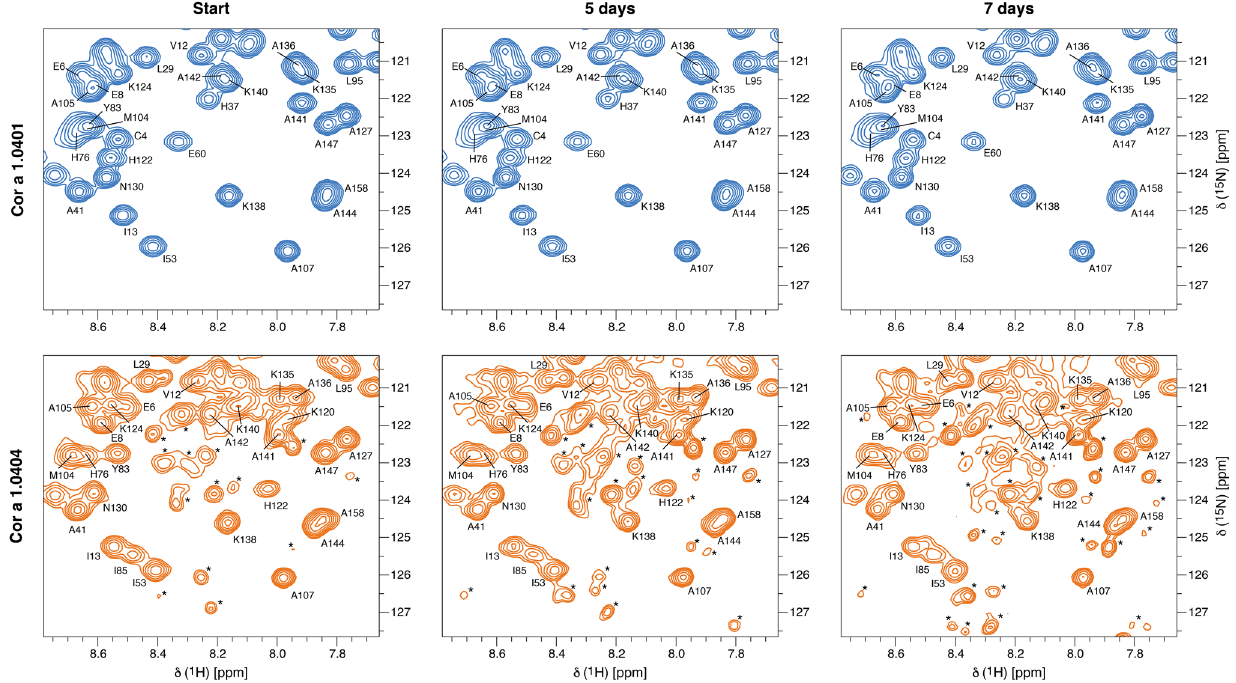
Figure 5. Time-dependent stability of Cor a 1.04 isoforms. Sections of 1 H– 15 N-HSQC spectra of Cor a 1.0401 (top) and Cor a 1.0404 (bottom) directly after purification, as well as 5 and 7 days later. Assignments 26 are indicated by single letter codes and signals labeled with an asterisk indicate aggregation and